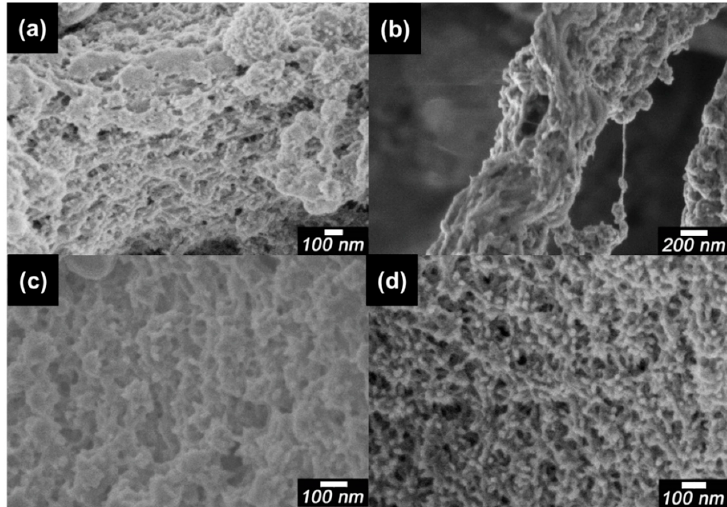
Figure 3. Scanning electron microscopy (SEM) images of PA-NF3 ( a ); PA-NF4 ( b ); PA-NF5 ( c ); and PA-NF6 ( d ). PA-NF3 (dried CNF/aniline = 50, feed %). PA-NF4, PA-NF 5, and PA-NF 6 were prepared by using 1% CNF suspension (CNF/aniline = 100, 50, 25, feed %).